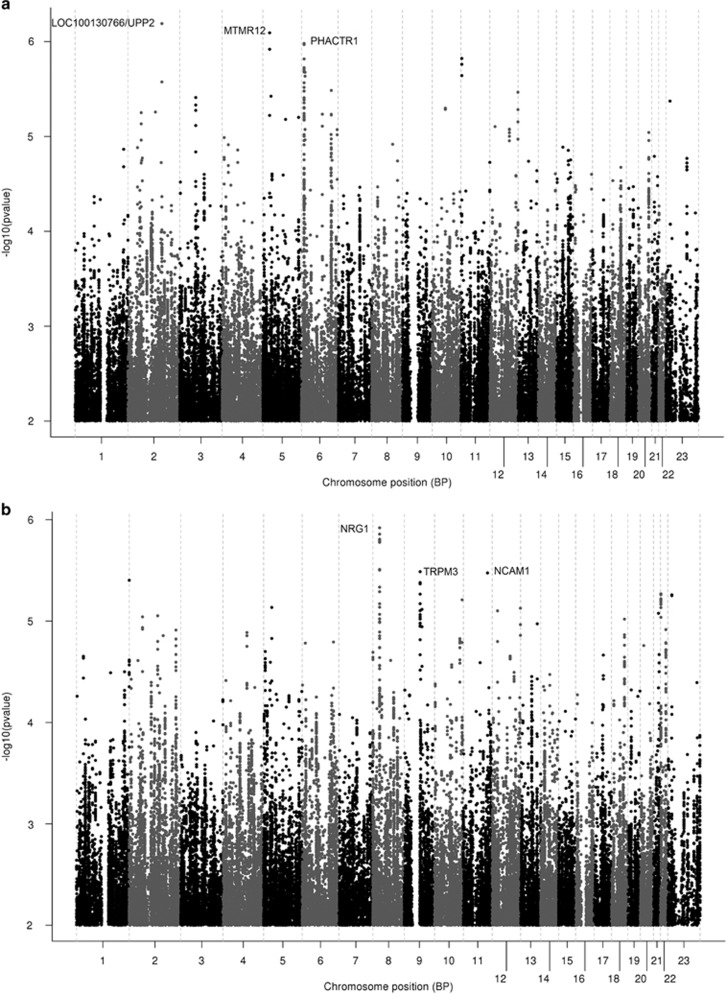
Manhattan plots showing genome-wide association results for the two outcome variables in the meta-analysis of ISPC, AMPS and STAR*D data. (a) %Δ depression score, (b) response. AMPS, Antidepressant Medication Pharmacogenomics Study; ISPC, International SSRI Pharmacogenomics Consortium; STAR*D, Sequenced Treatment Alternatives to Relieve Depression.